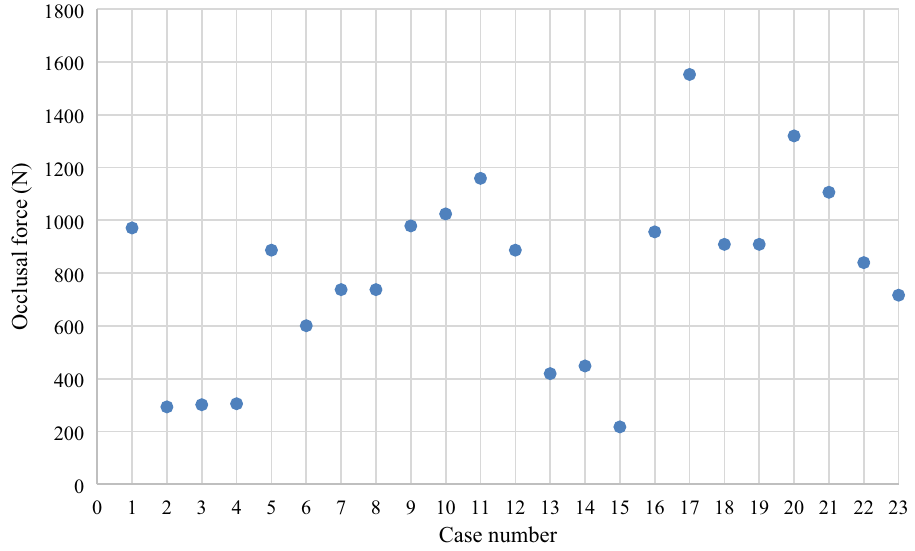
Figure 9. Distribution for the 23 subjects of Occlusal force evaluated by Dental prescale II system. *Plots represent mean Occlusal force for each case.